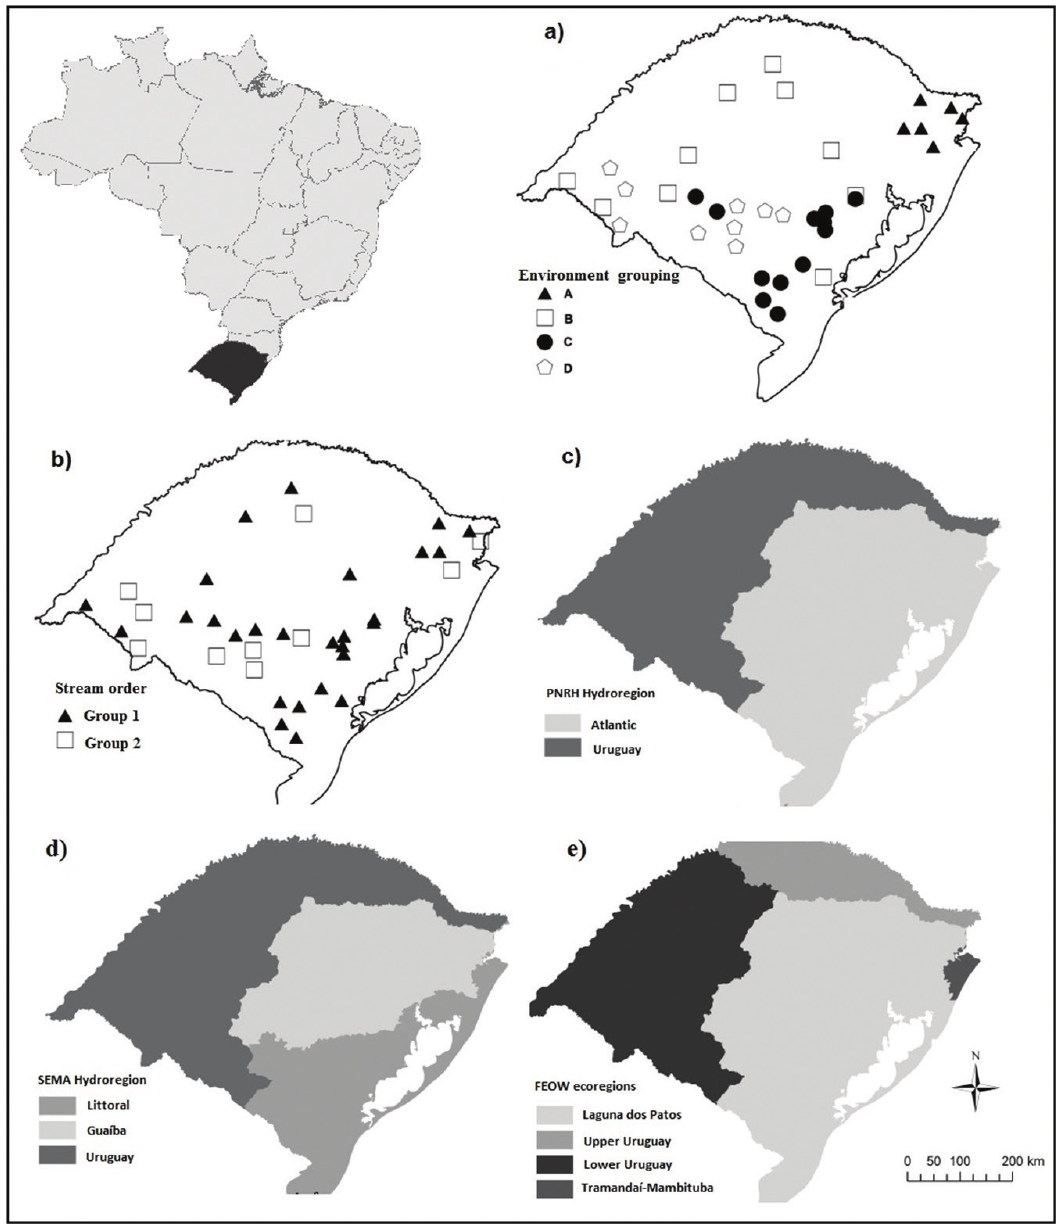
Figure 1. Stream classifications of Rio Grande do Sul state: a) Environment variables grouping , b) stream order grouping, c) PNRH hydroregions, d) SEMA hydroregions and e) FEOW ecoregions. For a and b each symbol represents a stream